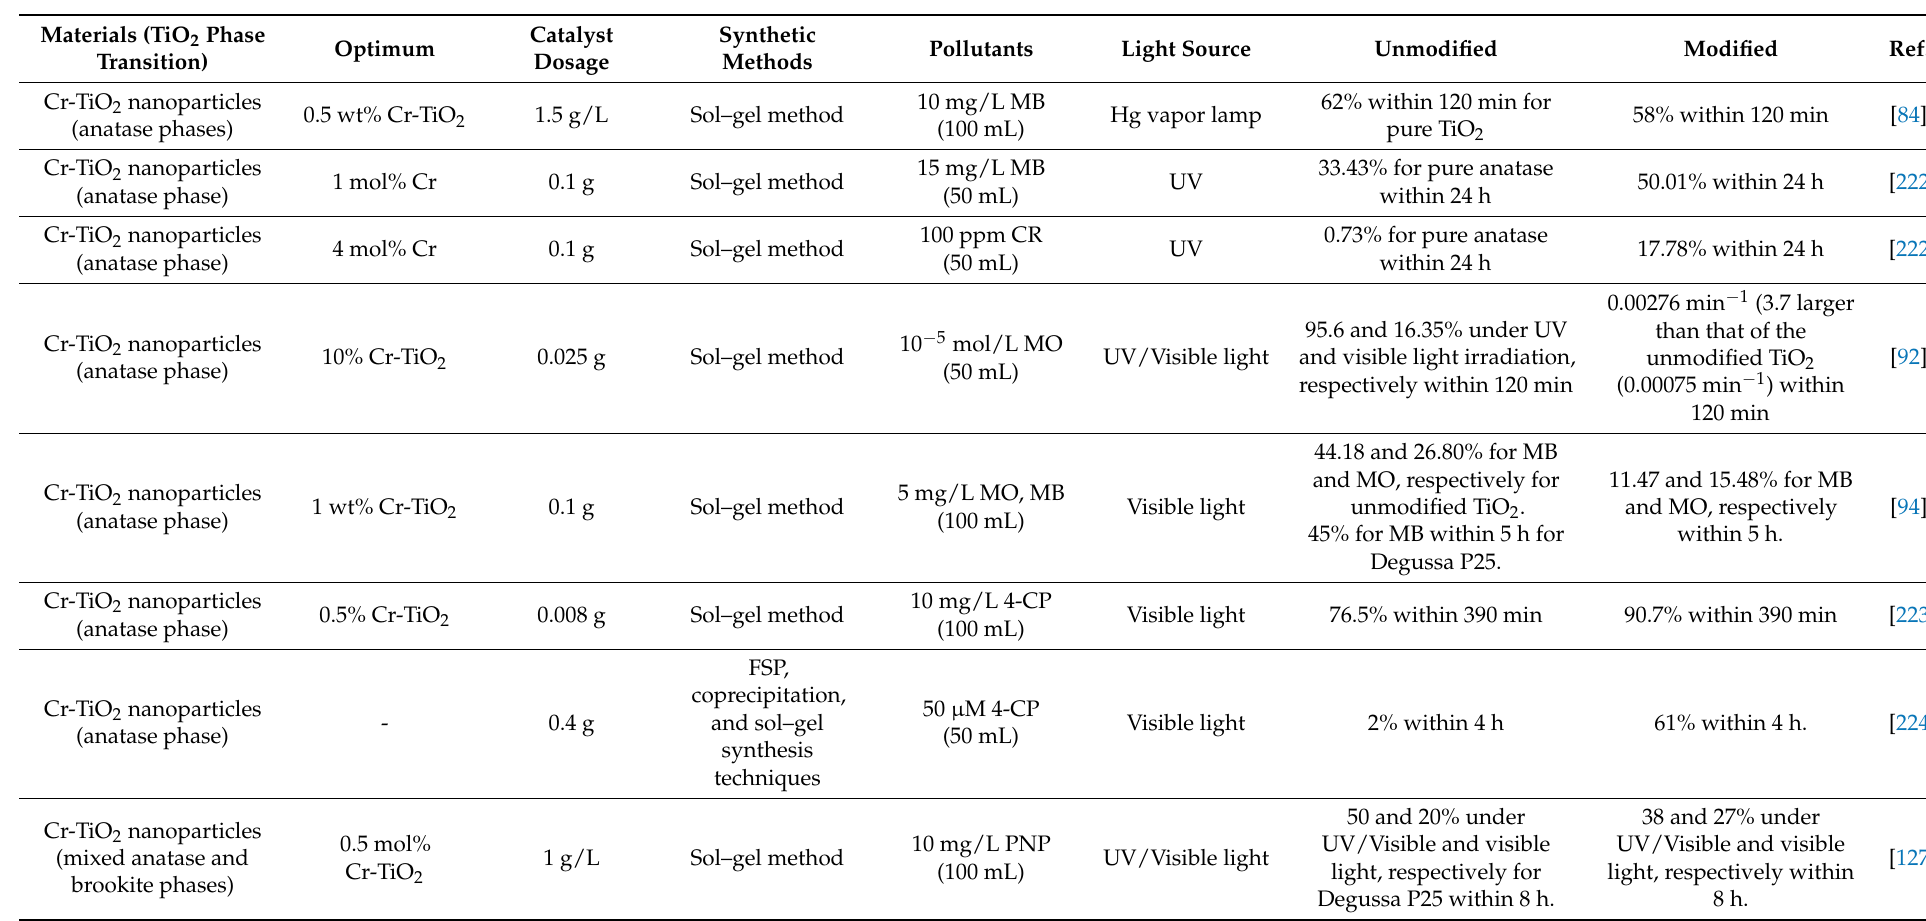
Table 9. Summary of recent progress on Cr-TiO 2 photocatalysts for organic pollutants